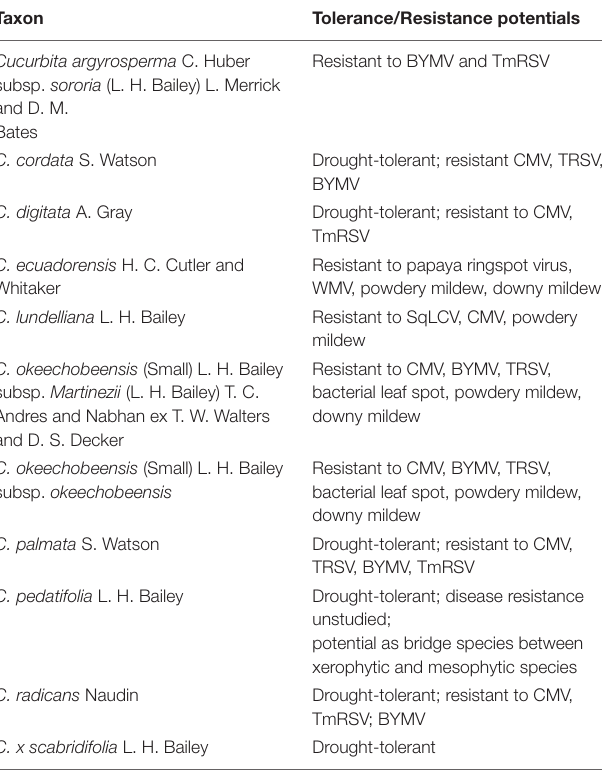
TABLE 9 | Wild relatives of genus Cucurbita and their documented tolerance/resistance potentials. Taxon Tolerance/Resistance potentials